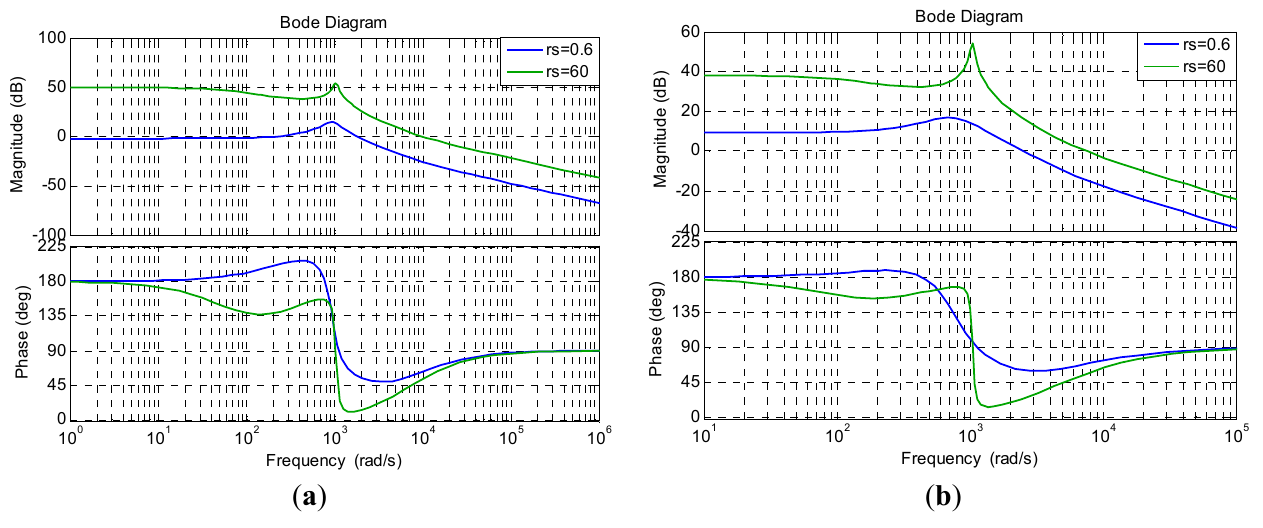
Figure 8. Bode plots of the Four-Switch type converter. ( a